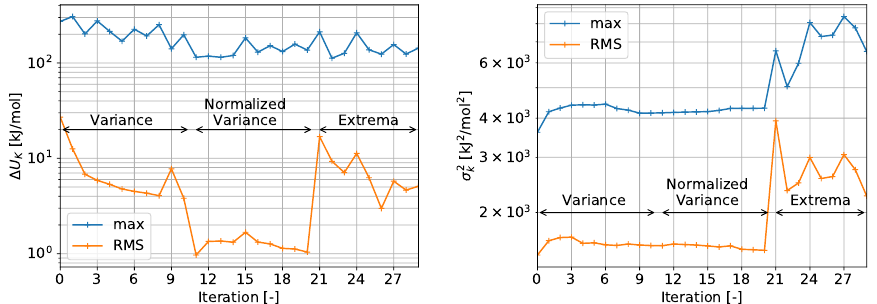
Figure 7. Convergence of the iterative resampling procedure for potential changes ( left , U i − U i − 1 ) and variance development ( right ). Figure adapted with permission from Ref. [66]. Copyright 2022,